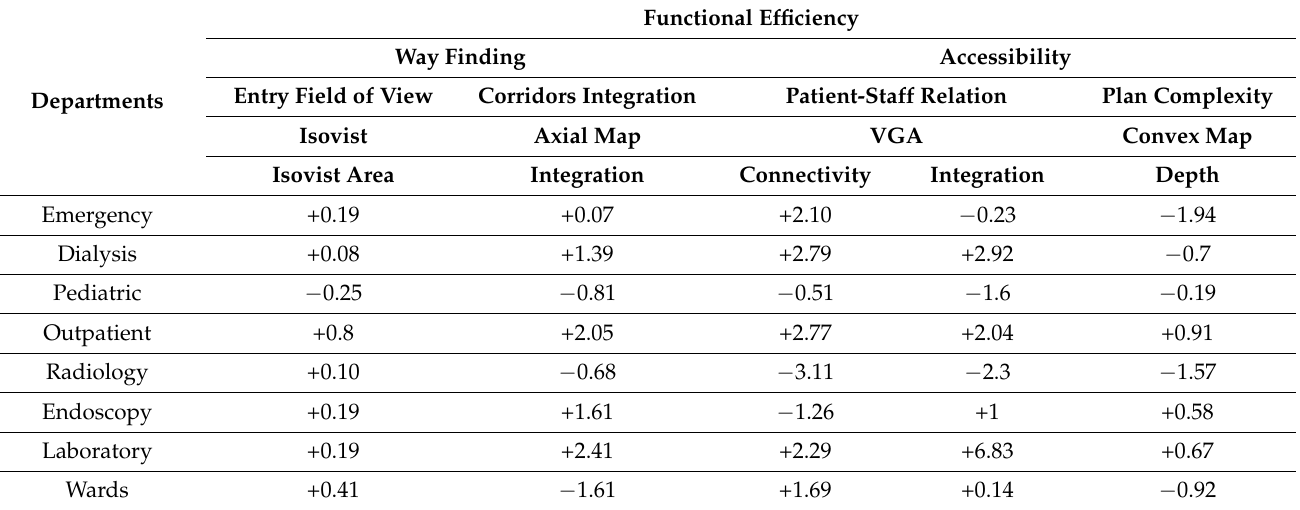
Table 17. Overall deferent rate in all space syntax analyses.